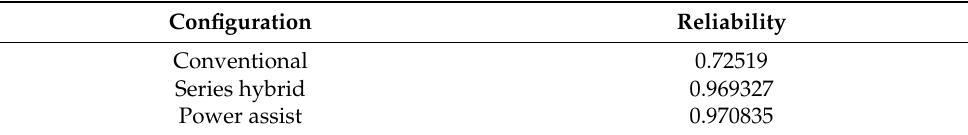
Table 7. Reliability of different system